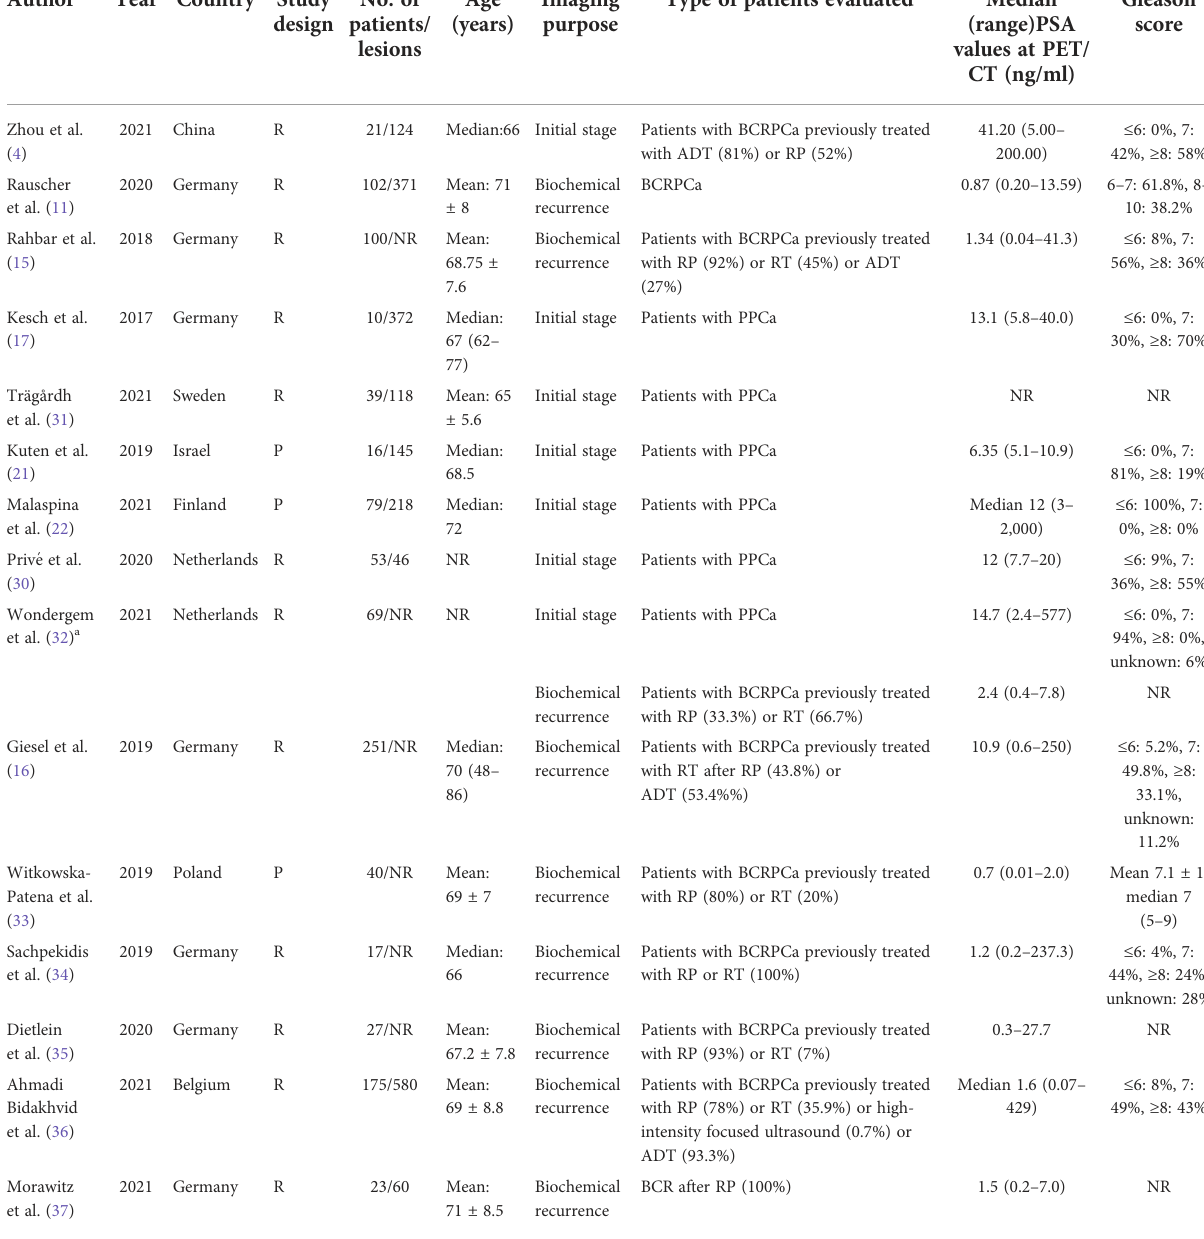
TABLE 1 Basic study and patient